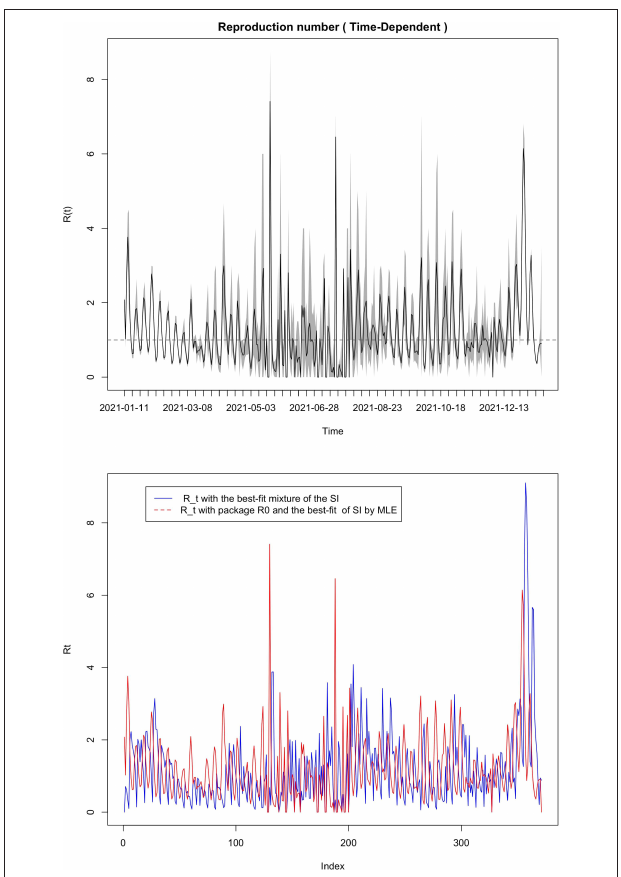
FIGURE 7 | Comparison of our time varying (figure below) reproductive number in Mayotte from 11 January 2021 to 11 January 2022 with the time-varying reproductive number from package R0 (figure above) with the best-fit of the SI by the MLE